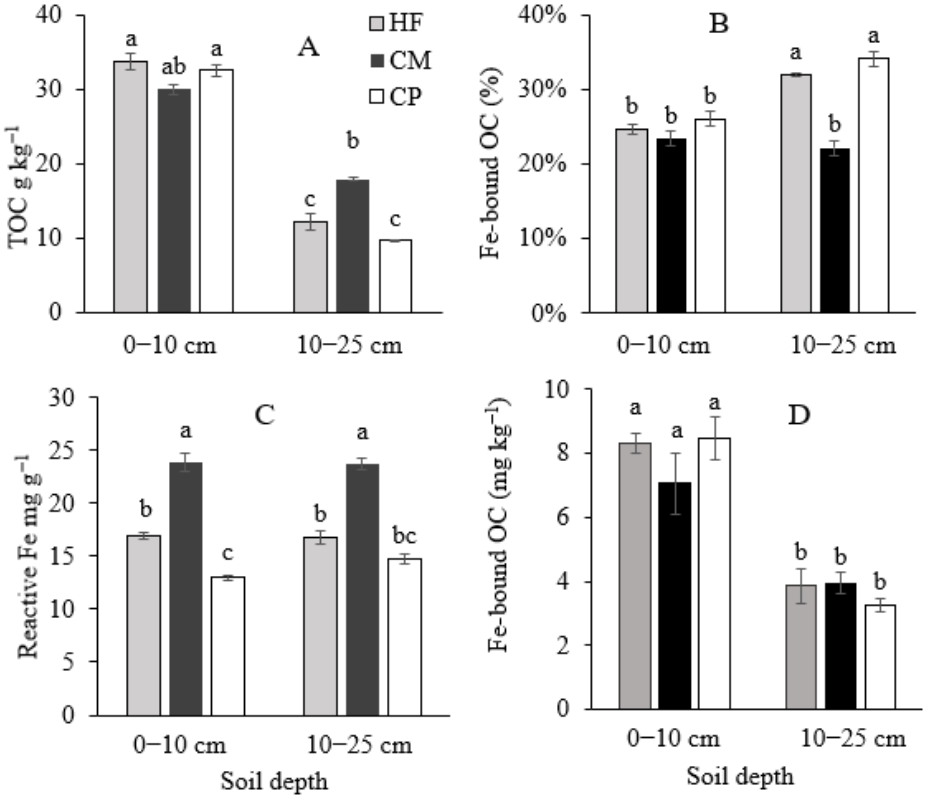
Figure 1. Total organic carbon (TOC) ( A ), organic carbon preserved by Fe (OC_Fe) ( B ), reactive Fe ( C ), and Fe-bound OC ( D ) in forest (HF), cropland (CM), and pasture (CP) soils at 0–10 cm and 10–25 cm depth. Different lower-case letters indicated significant differences at α = 0.05. The error bar represented the standard deviation (n = 3).